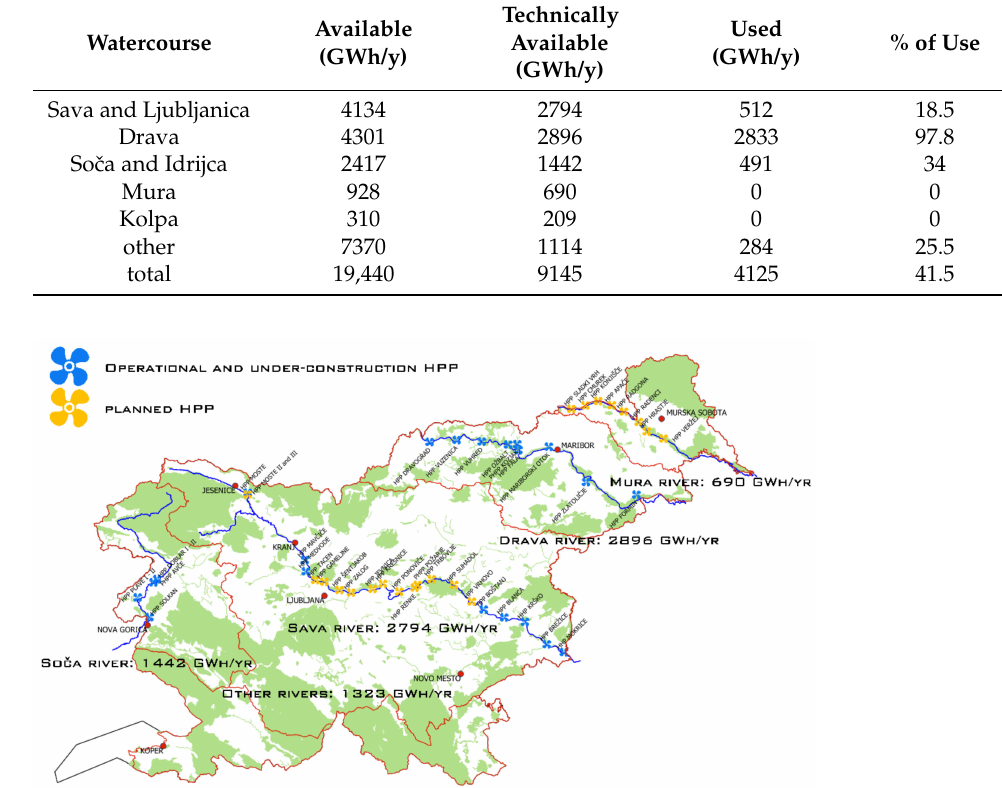
Table 1. The energy potential of Slovenian rivers [11].